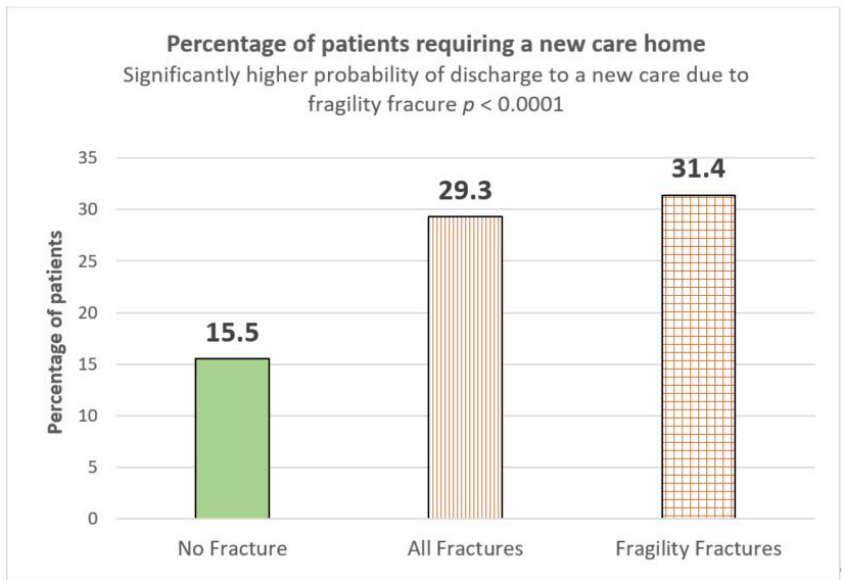
Figure 3. Patients requiring a new care home following an acute admission to hospital.